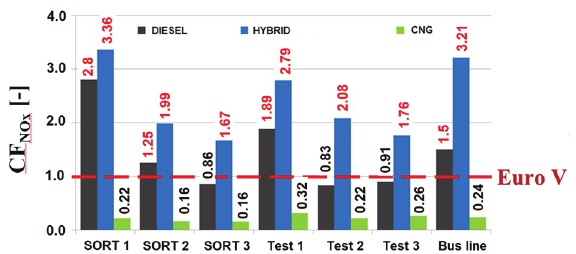
Fig. 30. Nitrogen oxides emission conformity factor CF NOx obtained from measurements in real operating conditions and the Euro V–EEV emission